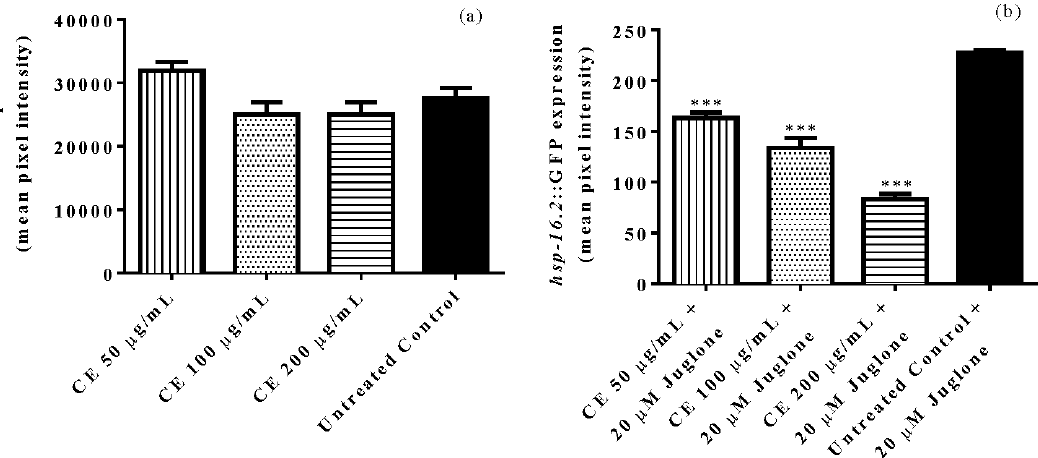
Figure 4. Quantification of the expression of stress response genes in mutant worms through fluorescence microscopy. Mutants CF1553 [(pAD76) sod -3::GFP + rol-6] treated with C. spruceanum extract (CE) exhibited no difference in sod-3::GFP expression when compared with the untreated control group ( a ). After 20 µ M juglone exposure, mutants TJ375 [ hsp -16.2::GFP(gplsI)] treated with CE exhibited lower expression of hsp-16::GFP compared with the untreated control ( b ). The results are presented as mean ± SEM from three independent assays. *** p < 0.001, as compared to the untreated control by one-way ANOVA followed by Bonferroni (post-hoc).